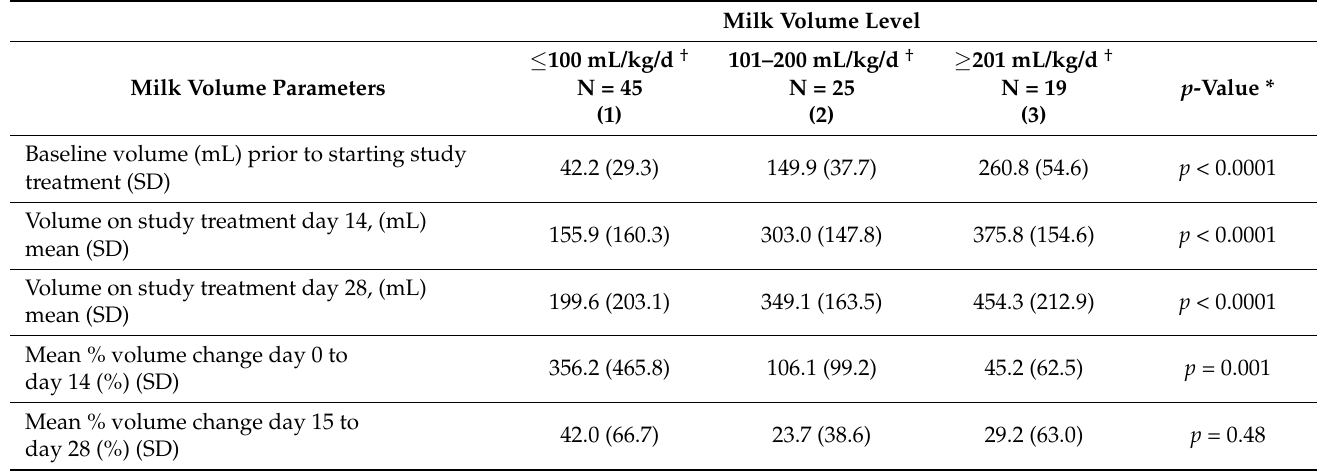
Table 2. Milk volumes at study time points day 0, day 14, and day 28.